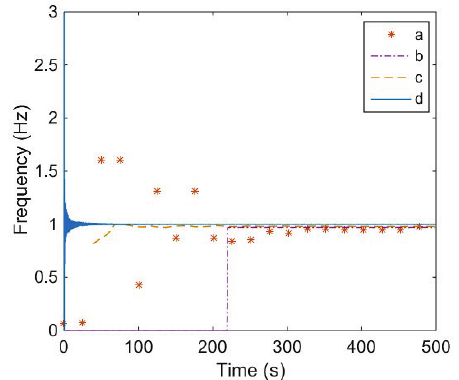
Figure 6. Simulation results of different